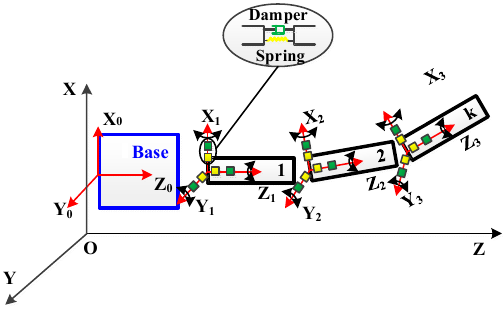
Figure 1. The simplified model of space manipulator.